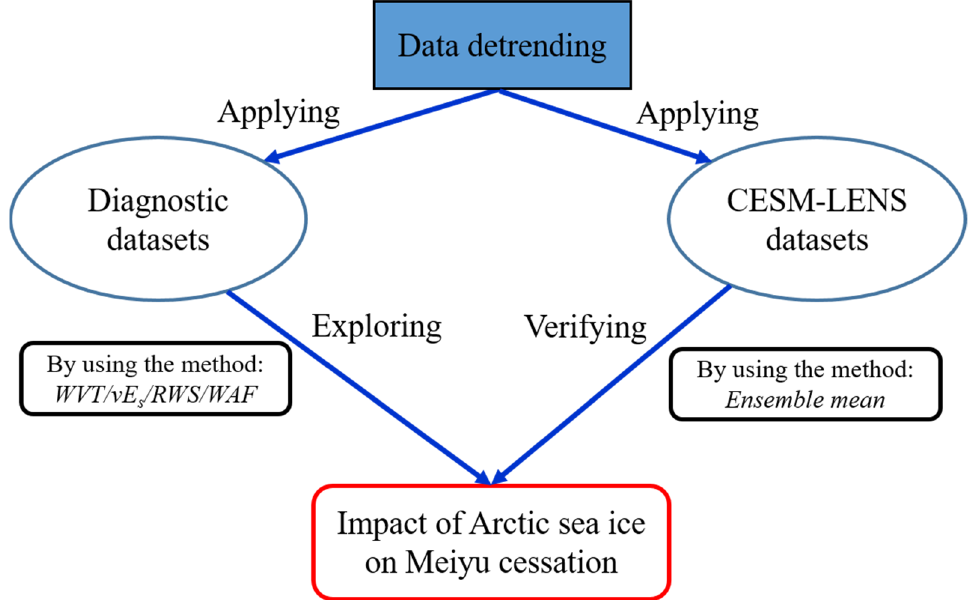
Figure 1. Basic flow chart of the methodology.